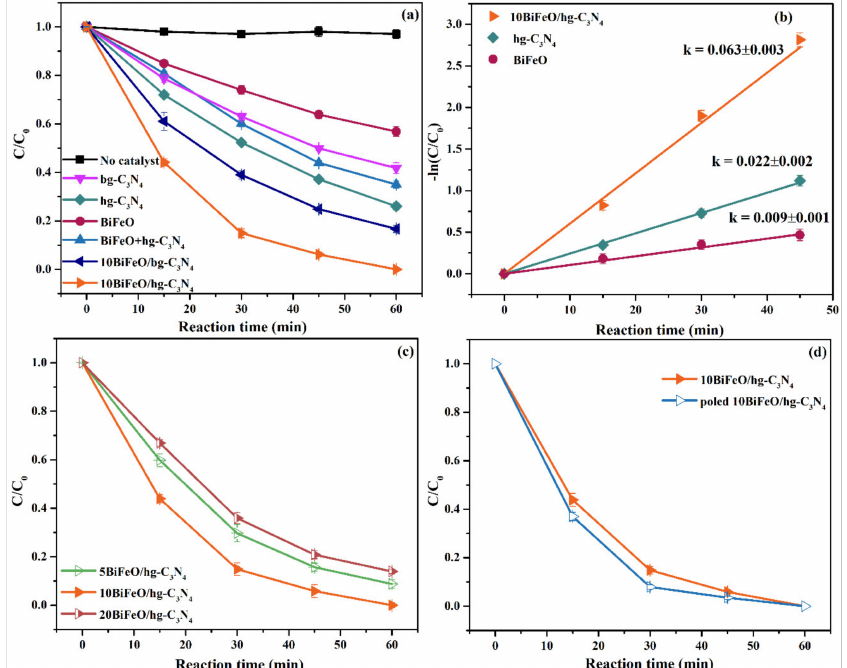
Figure 5. Photocatalytic degradation of RhB: ( a ) the synthesized g-C 3 N 4 , BiFeO and BiFeO/g- C 3 N 4 samples; ( b ) the pseudo-first-order kinetics curves of BiFeO, hg-C 3 N 4 and 10BiFeO/hg-C 3 N 4 ; ( c ) x BiFeO/hg-C 3 N 4 (5%, 10%, and 20% BiFeO 3 ); ( d ) electrically poled 10BiFeO/hg-C 3 N 4